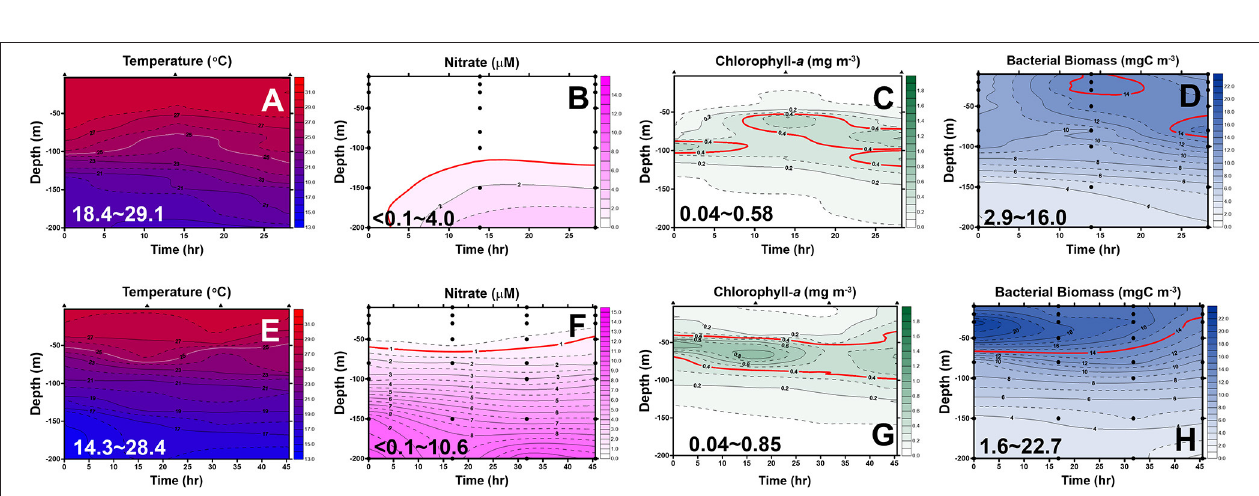
FIGURE 4 | The temperature–salinity diagrams of the first-cast (blue lines) (A–H) and last-cast (I–P) deployed at stations 8, 7, and 1–6 of the July cruise. The black and red dashed lines represent the typical KC and SCS waters, respectively. The data were collected from the Ocean Data Bank, Taiwan (http://www.odb.ntu.edu. tw/). The first and second numbers of the abbreviation St. x–x in each panel indicate the sampling station and the hydrocast deployed at that station, respectively.